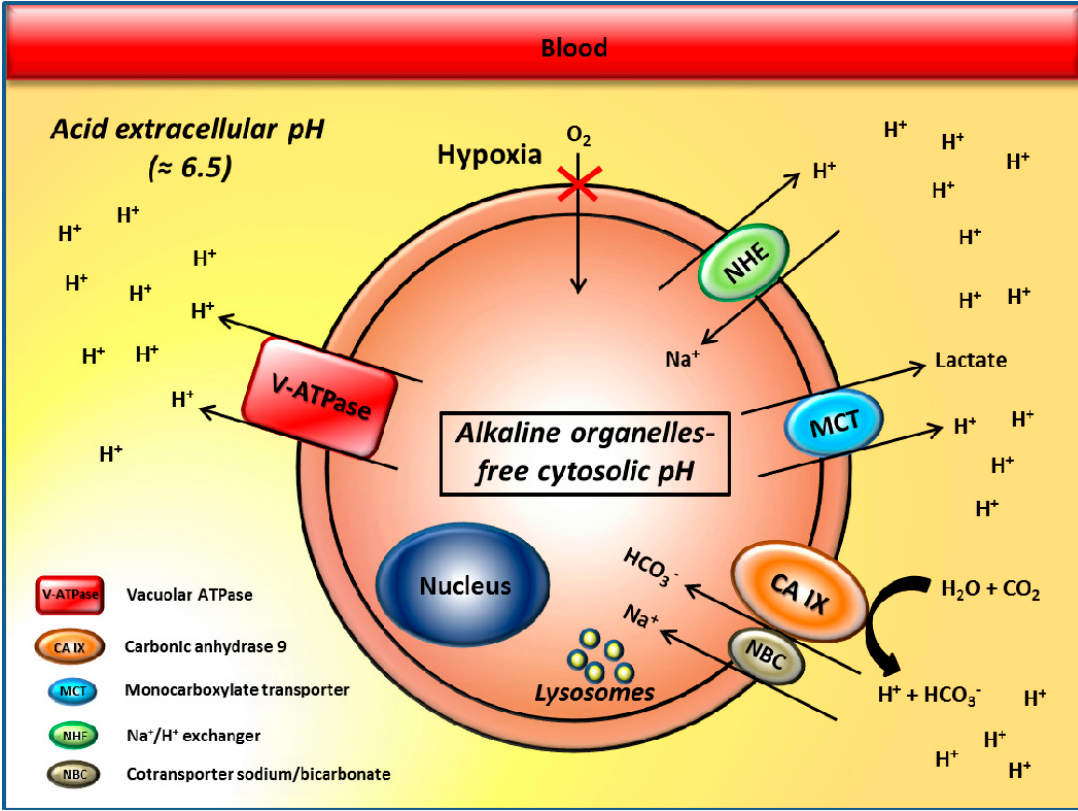
Figure 1. Proton flux regulators and their role in cancer. The aberrant expression and activity of proton exchangers leads to acidification of the tumor microenvironment and creates a reversed pH gradient across the plasma membrane leading to extracellular acidity and an alkaline, organelle-free cytosol.